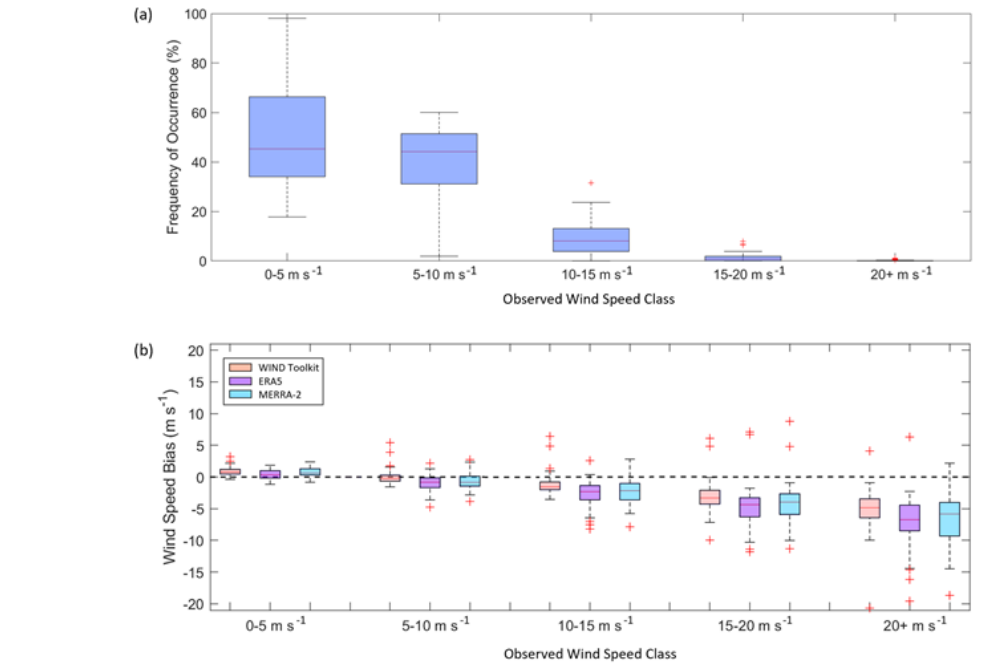
Figure 5. (a) Frequency of occurrences of observed wind speeds and (b) distance-weighted model wind speed bias according to observed wind speed class. The median biases are indicated with the red lines; the 25th and 75th percentiles form the blue boxed range; the minimum and maximum error metrics, excluding outliers, are in black; and outliers are indicated with red plus